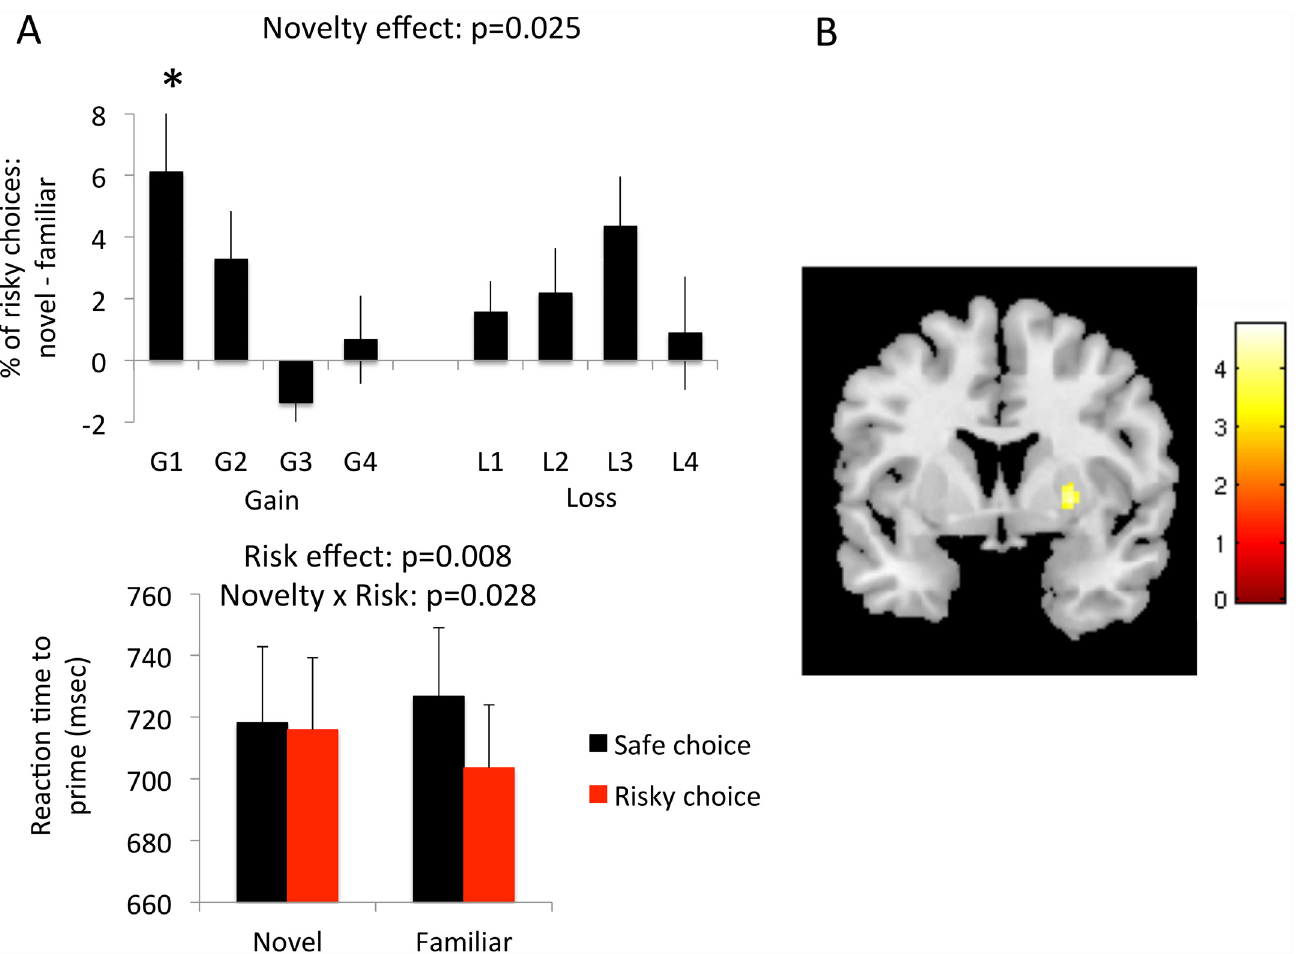
Fig 2. Behavioural and imaging findings. A. The top graph shows the percentage of risky choices of novel versus familiar primes as a function of different gain (+0 to +40 divided by +10) and loss magnitudes (-0 to -20 divided by -5). The bottom graph shows the reaction time to the novel and familiar prime as a function of the safe or risky choice. * post-hoc p = 0.001 significant after Bonferroni correction. B. The coronal image shows that greater right putaminal BOLD activity of the novel versus familiar prime contrast was positively correlated with greater subsequent risky choices across subjects following exposure to the novel versus familiar